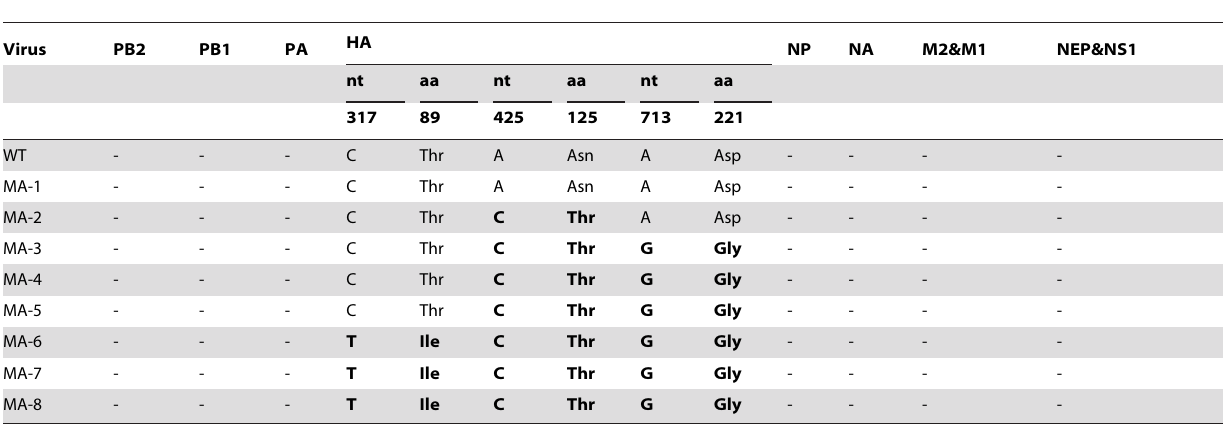
Table 2. Sequence alignment of wild-type and mouse-adapted seasonal H1N1 A/Brisbane/59/2007 viruses of each passage.